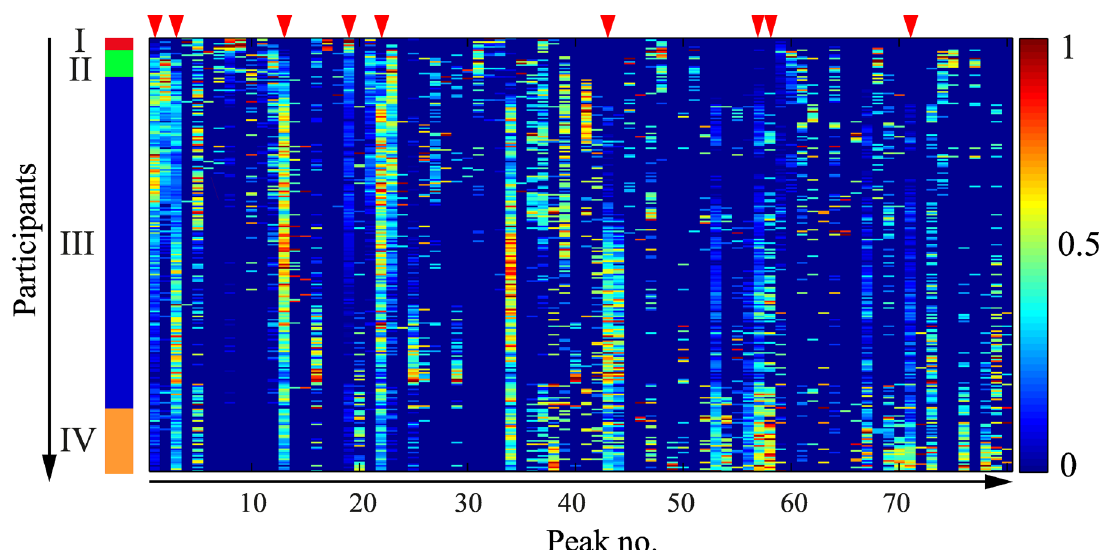
Fig 2. Overview of the peptide profile variation within the study population. The X-axis contains the 80 peaks ordered by their m/z ratio, (lowest to highest, from left to right). The Y-axis contains the 261 participants, arranged according to the co- occurrence matrix (same as in Fig 1). Data for each individual peak were scaled to equal range (from 0 to 1) and color coded (legend on the right side of the figure). The vertical bar on the left delimits the four clusters. Red arrows on the upper margin highlight the 9 peaks shown by Unsupervised Feature Selection to be determining the clustering structure (Fig 1).